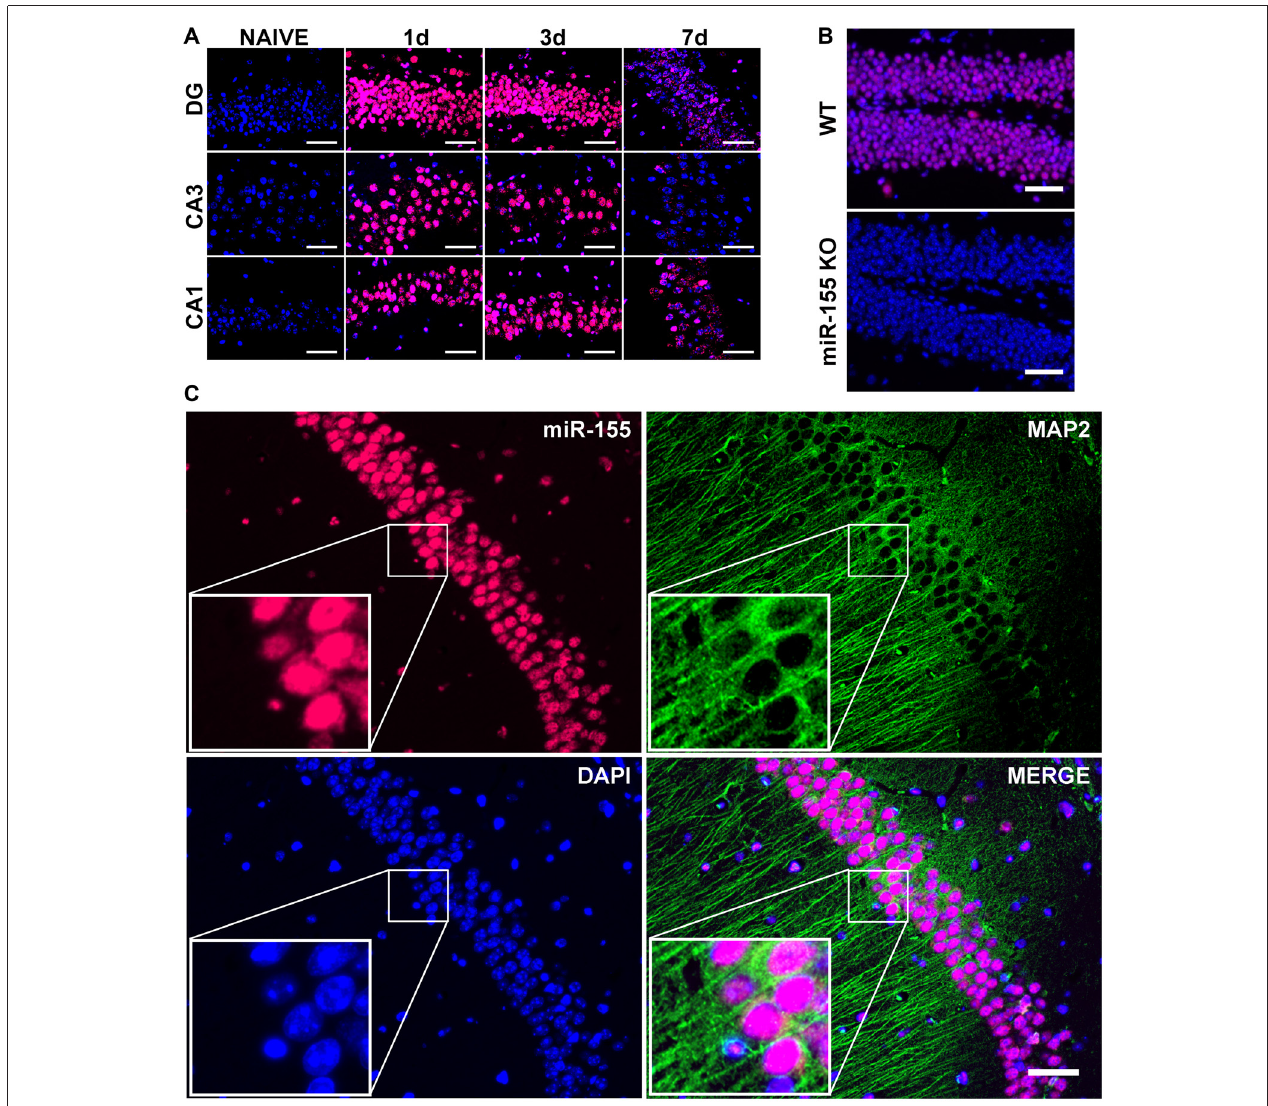
FIGURE 2 | Nuclear, neuronal localization of miR-155 in the hippocampus after CCI. (A) Fluorescence in situ hybridization (FISH) for miR-155 1, 3 and 7 days after moderate CCI and in naïve mice. Dentate gyrus (DG), CA1 and CA3 of the ipsilateral hippocampus are shown. (B) miR-155 expression in the ipsilateral DG of wild type (WT) and miR-155 knock out (KO) mice 3 days after severe CCI. (C) FISH and Co-IHC was performed for neuronal marker MAP2 (green), nuclei (blue), miR-155 (magenta). Scale bars = 50 µ M.